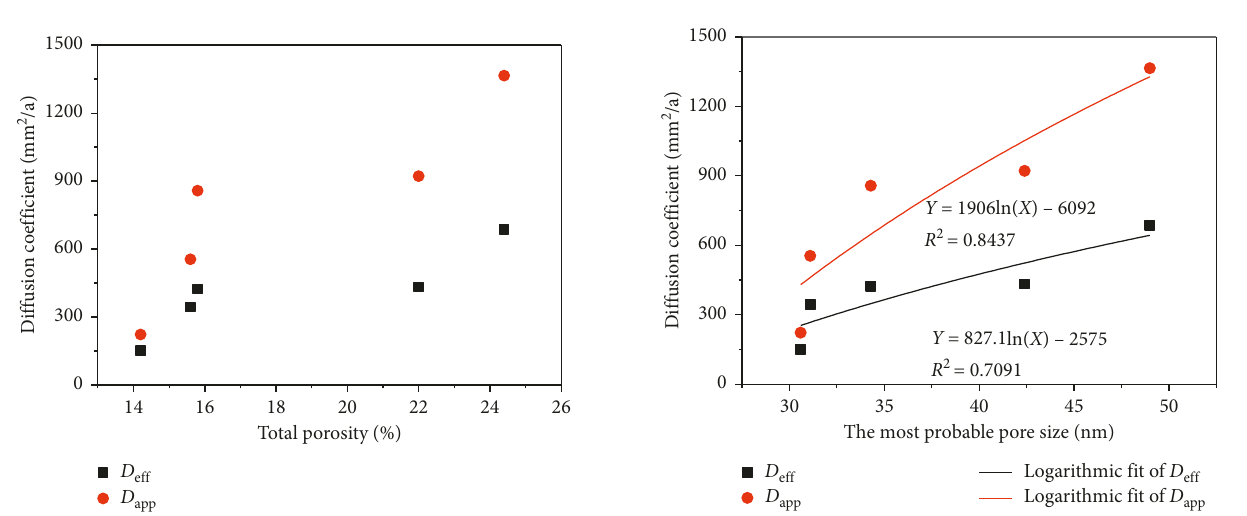
Figure 8: Relation between pore structure parameters and S absorption